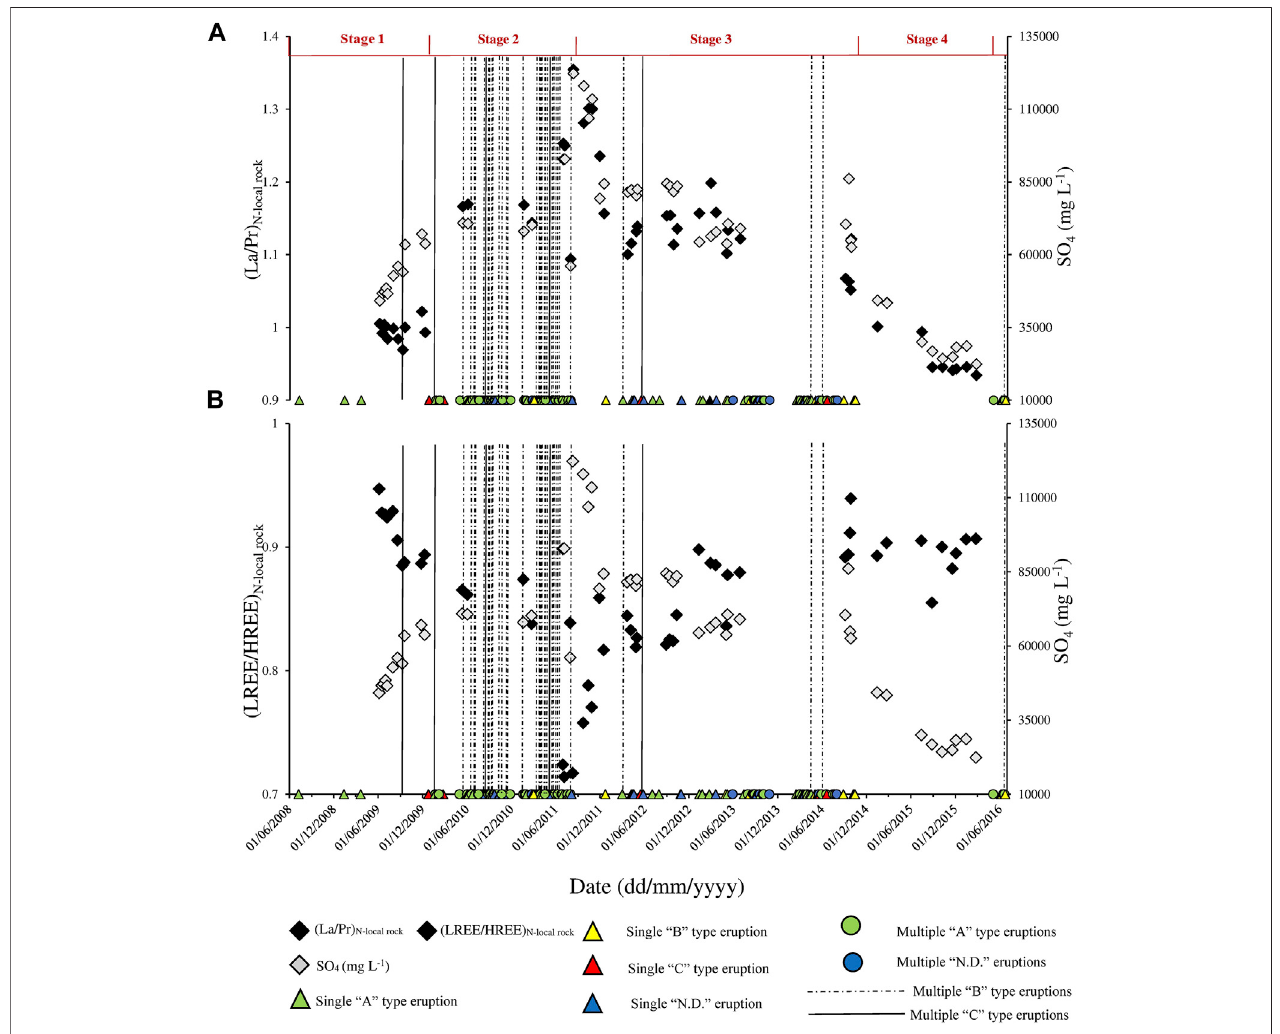
FIGURE 8 | (A) (La/Pr) N-local rock and SO 4 vs. time. (B) (LREE/HREE) N-local rock and SO 4 vs. time.